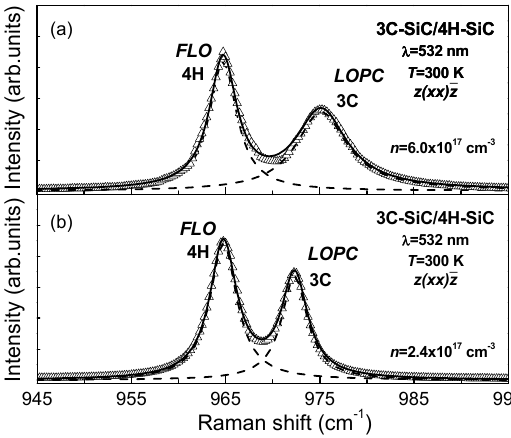
Figure 4. Polarized Raman spectra of the heterostructure in the range of the LOPC modes: ( a ) as grown, and ( b ) after the irradiation with 8 MeV protons at irradiation dose of 6.0 × 10 15 cm − 2 .